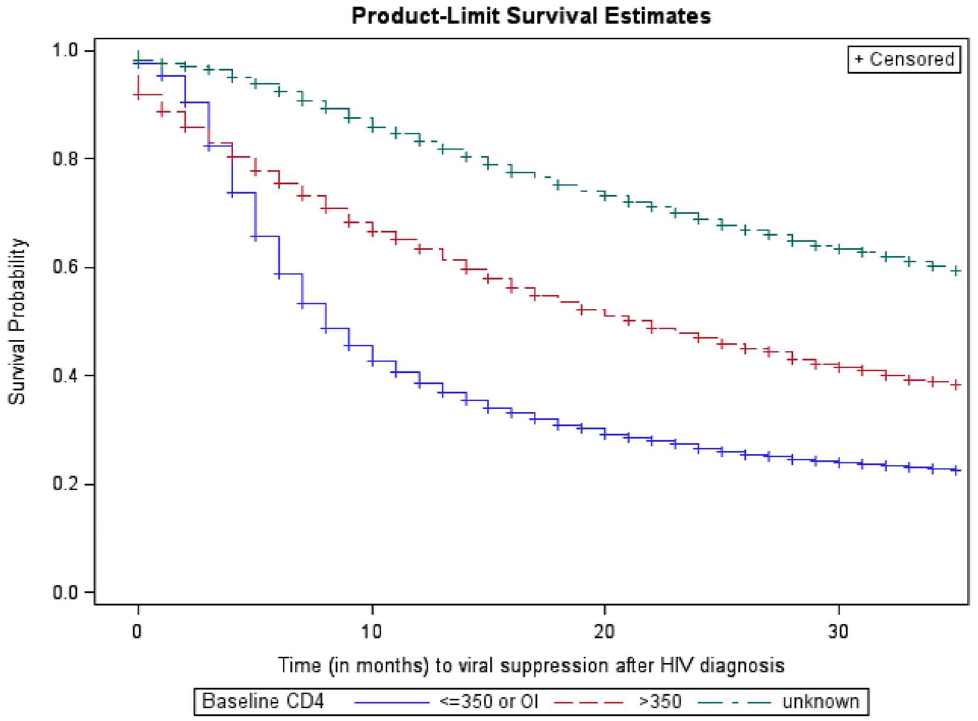
Figure 2. Kaplan-Meier survival curve for time from HIV diagnosis to viral suppression, by baseline CD4 count.